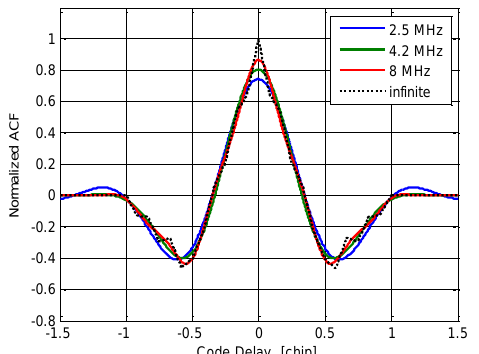
Figure 6. ACF of Galileo E1 B signal for different RF front-end bandwidths.